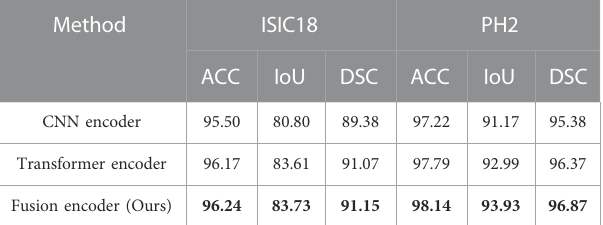
TABLE 3 Quantitative results for the ablation study on the encoder. The best results are shown in